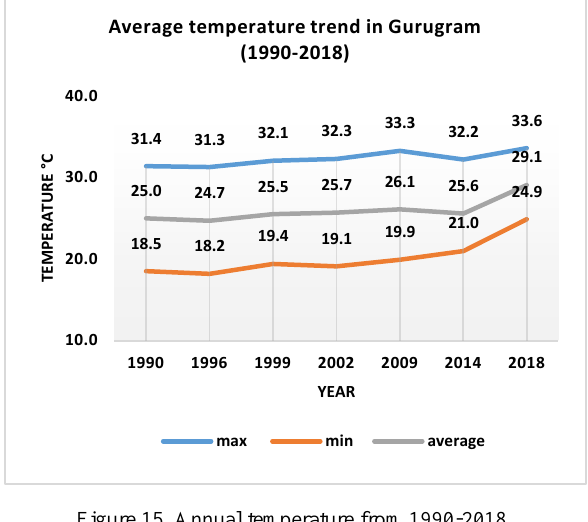
Figure 15. Annual temperature from 1990-2018